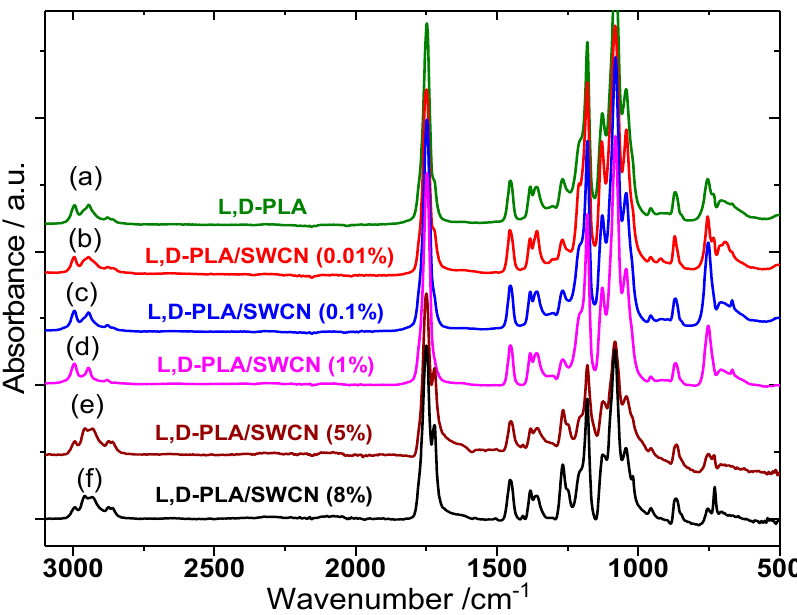
Figure 14. FT-IR spectra of L , D -PLA and L , D -PLA/SWCN composites ( a – f ) obtained at 293 K.